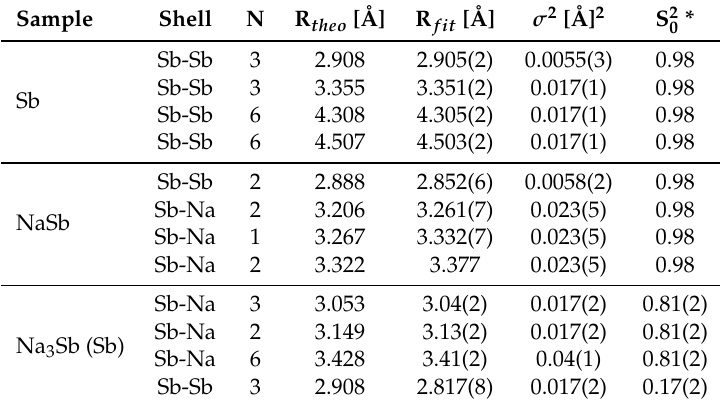
Table 3. EXAFS fitting parameters for Sb and the Na-Sb